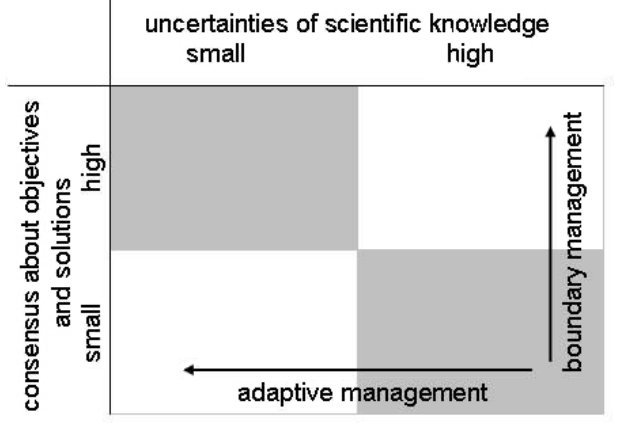
Fig. 1. Managing the recreation–biodiversity conflict with the frameworks of adaptive management and boundary management. Figure modified from Hanssen et al.